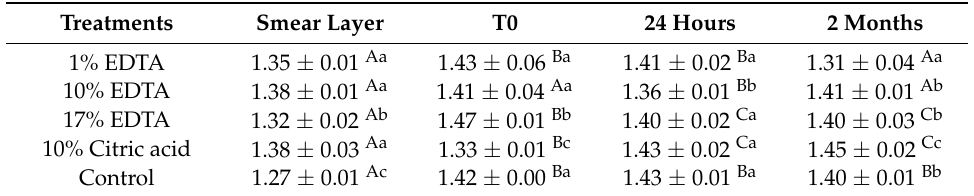
Table 4. Ca/P atomic ratios (mean ± SD). In columns, identical superscript lowercase letters represent no statistical differences (two-way ANOVA followed by an RM Student–Newman–Keuls test) among tested solutions ( P ≥ 0.05). In the horizontal rows, identical superscript uppercase letters represent no statistical differences (one-way ANOVA for repeated measures followed by an RM Student–Newman–Keuls test) among evaluation times ( P ≥ 0.05).